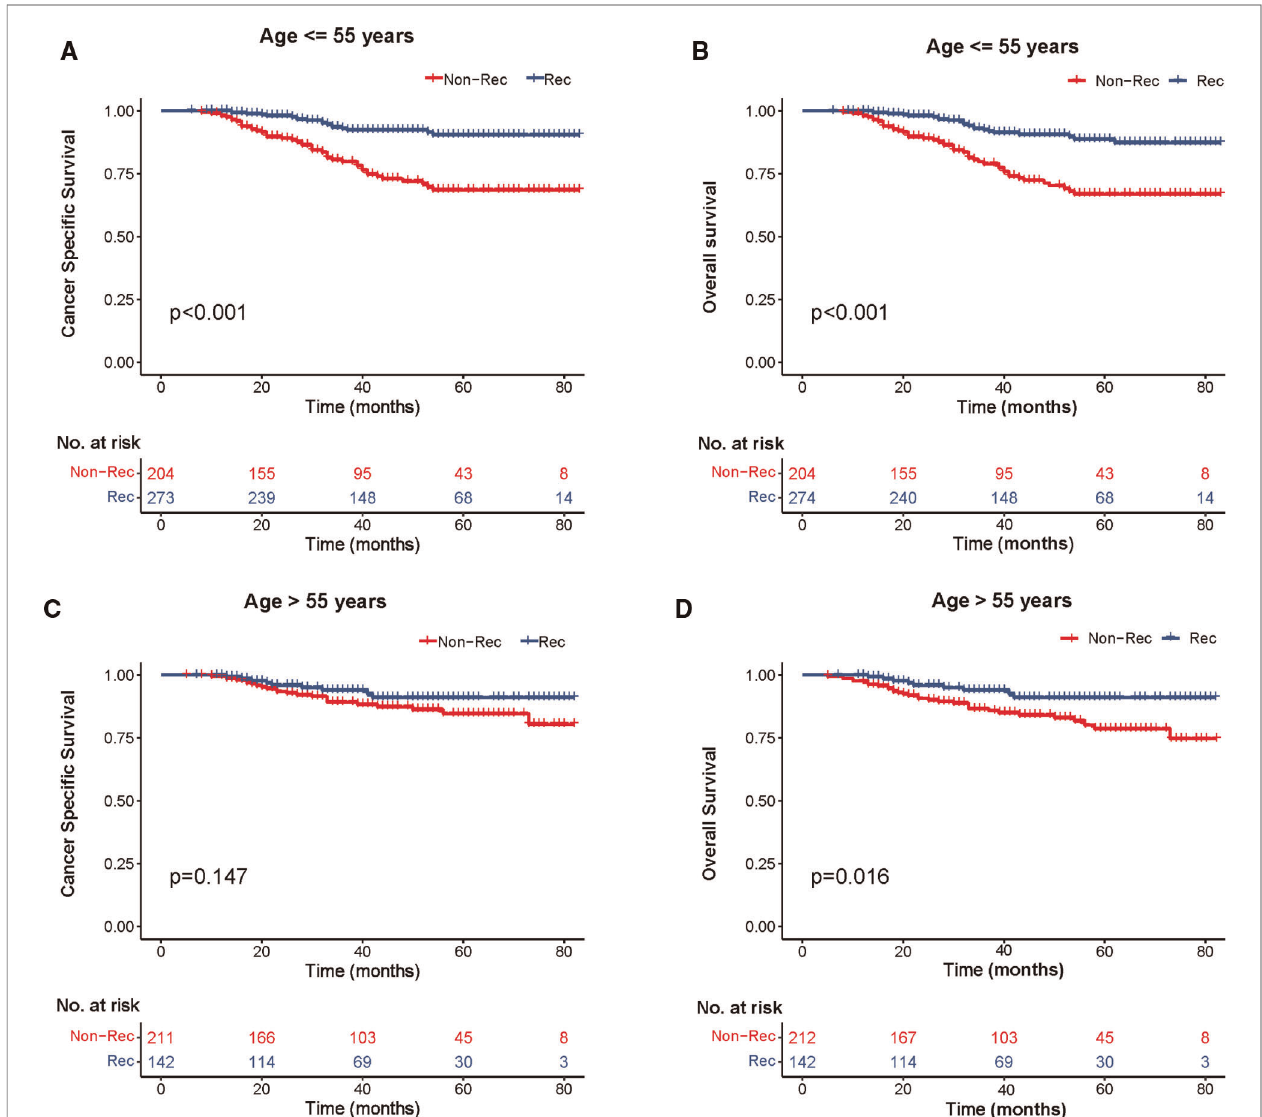
FIGURE 3 | Kaplan – Meier curves of breast cancer-speci fi c survival and overall survival in the reconstruction and non-reconstruction groups strati fi ed by different ages. ( A ) Age ≤ 55 years, ( B ) Age ≤ 55 years, ( C ) Age >55 years, and ( D ) Age >55